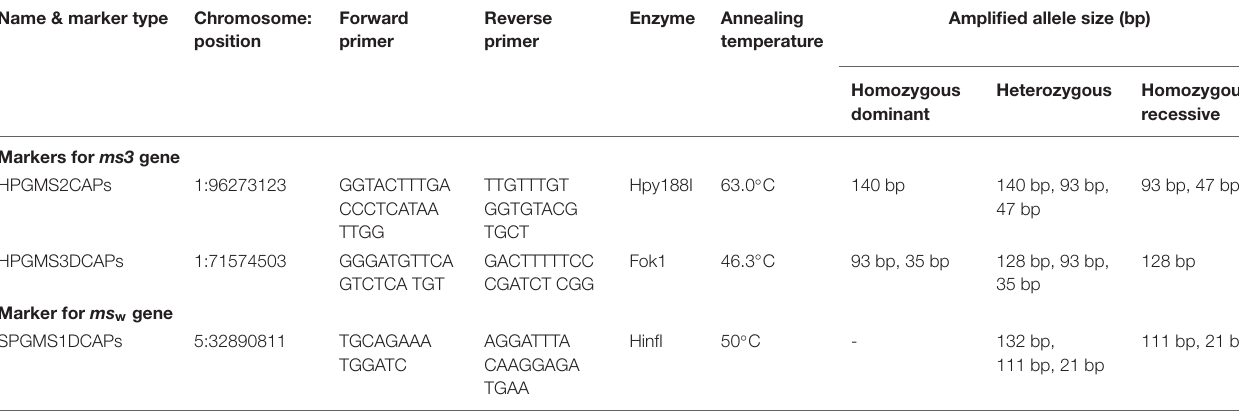
TABLE 2 | Primer sequences and amplification profile of markers for ms3 and ms w genes in